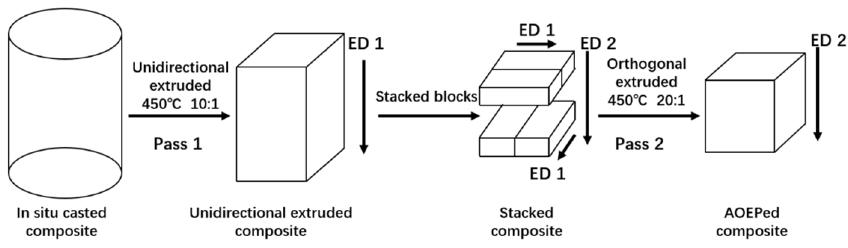
Figure 1. Schematic of accumulative orthogonal extrusion process (AOEP). ED: extrusion direction.